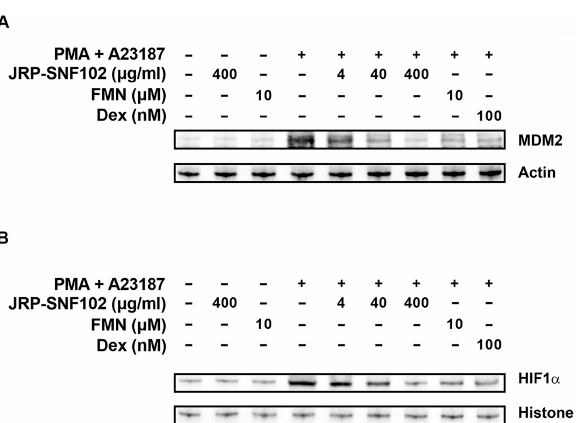
Figure 3. An inhibitory effect of JRP-SNF102 or FMN on MDM2 expression. HMC-1 cells were incubated with or without JRP-SNF102, FMN, or Dex for 1 h, followed by PMA and A23187 stimulating for 3 h. ( A ) MDM2 level was determined by Western blotting. ( B ) HMC-1 cells were incubated with or without JRP-SNF102, FMN, or Dex for 1 h, followed by PMA and A23187 stimulating for 4 h. HIF1 α level in nucleus was determined by Western blotting. -, non-treatment; +, treatment.